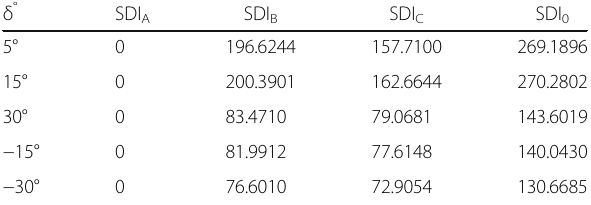
Table 4 SDI values during different loading angle